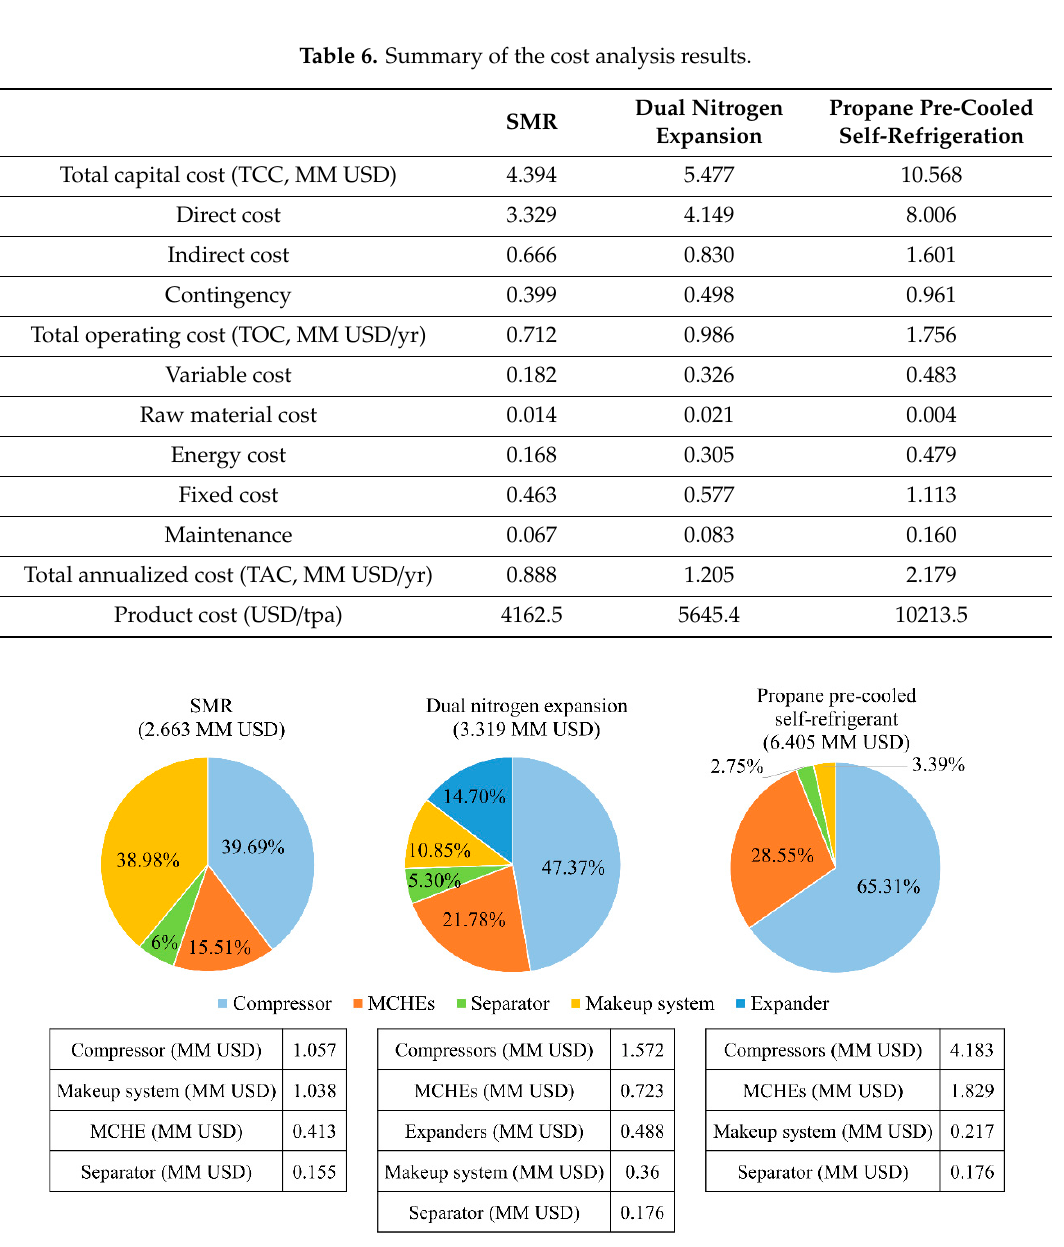
Figure 8. Breakdown of the total equipment cost.